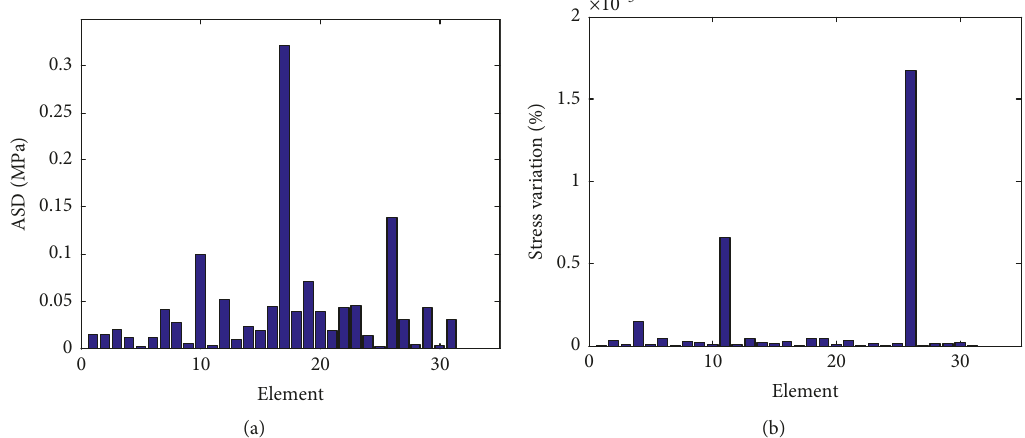
Figure 18: Multiple damages at elements 10 , 17 , and 26 using 3% noise and local-based approach of (a) ASD and (b) stress variation